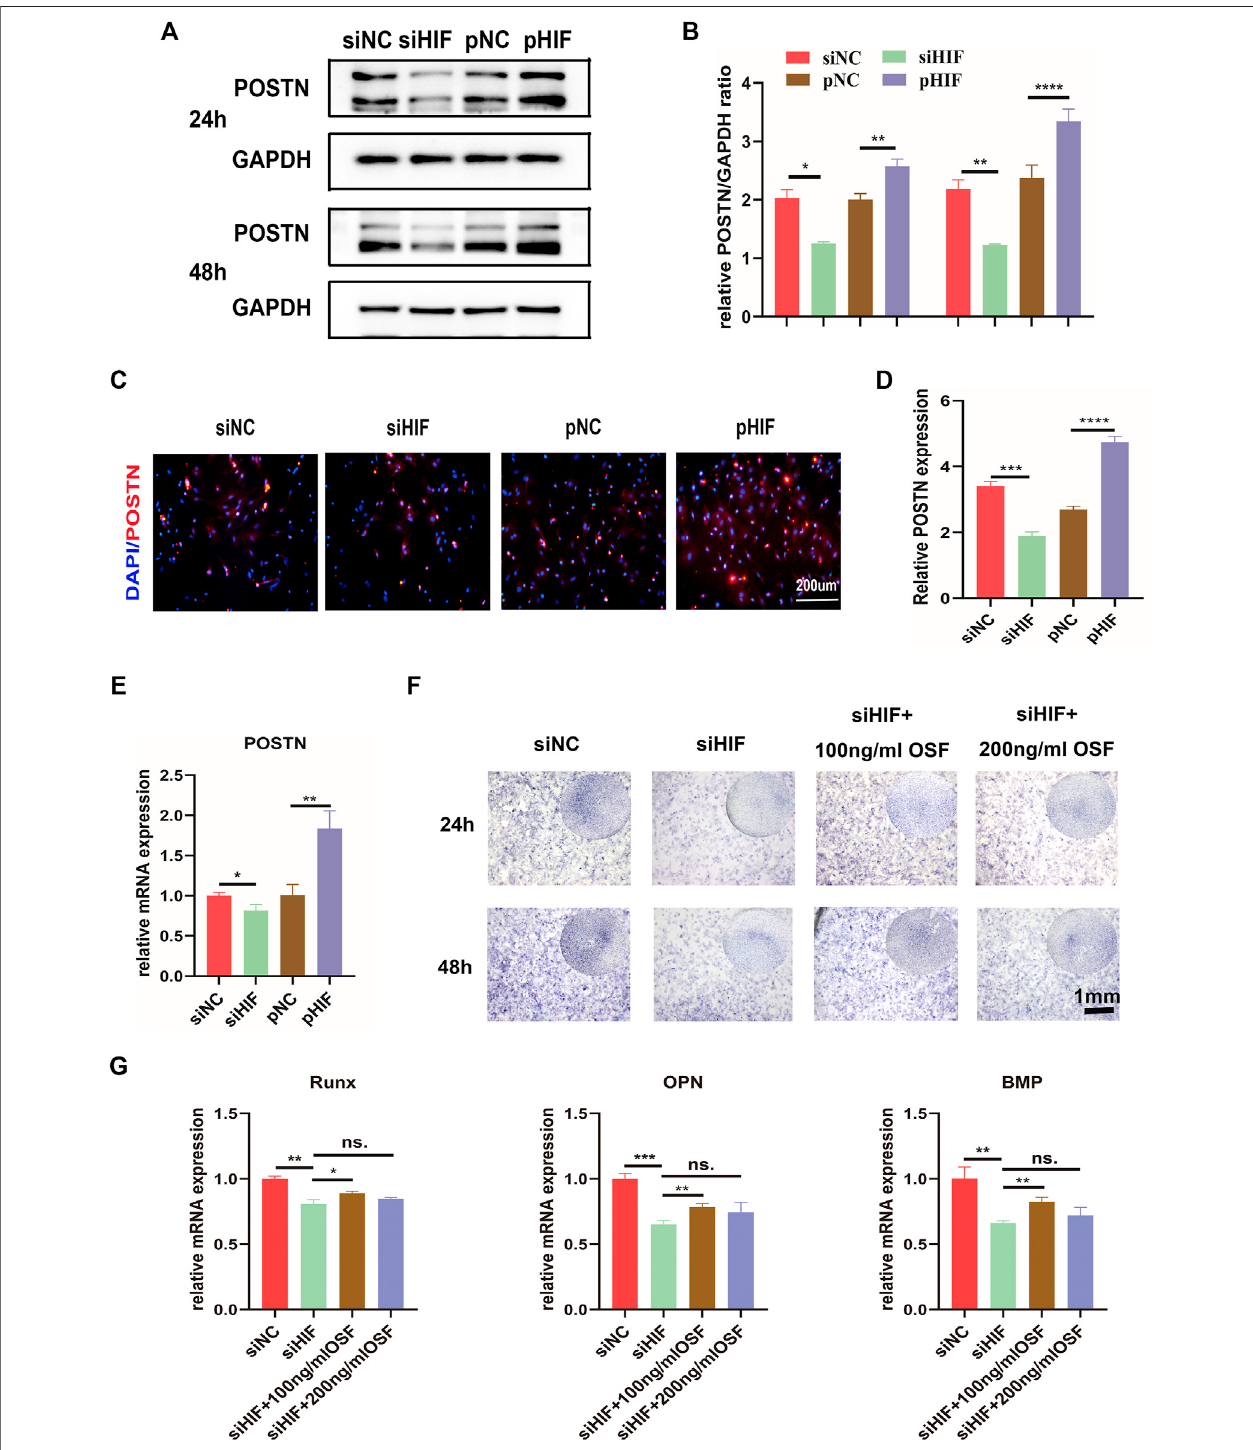
FIGURE 4 | HIF-1 α regulates osteogenesis via POSTN. (A,B) Western blotting of POSTN expression in PDSCs after siHIF-1 α and pHIF-1 α transfection and semi- quanti fi cation. (C,D) Theimmuno fl uorescenceforPOSTNintransfectedPDSCsandthesemi-quanti fi cation. (E) ThemRNAexpressionofPOSTNbyqRT-PCR. (F) ALP staining of the PDSCs after transfection, with or without the addition of POSTN. (G) The expression of the osteogenic related genes. * indicates the signi fi cance tests between groups: * p < 0.05, ** p < 0.01, *** p < 0.001, **** p < 0.0001; and ns: no signi fi cant difference.